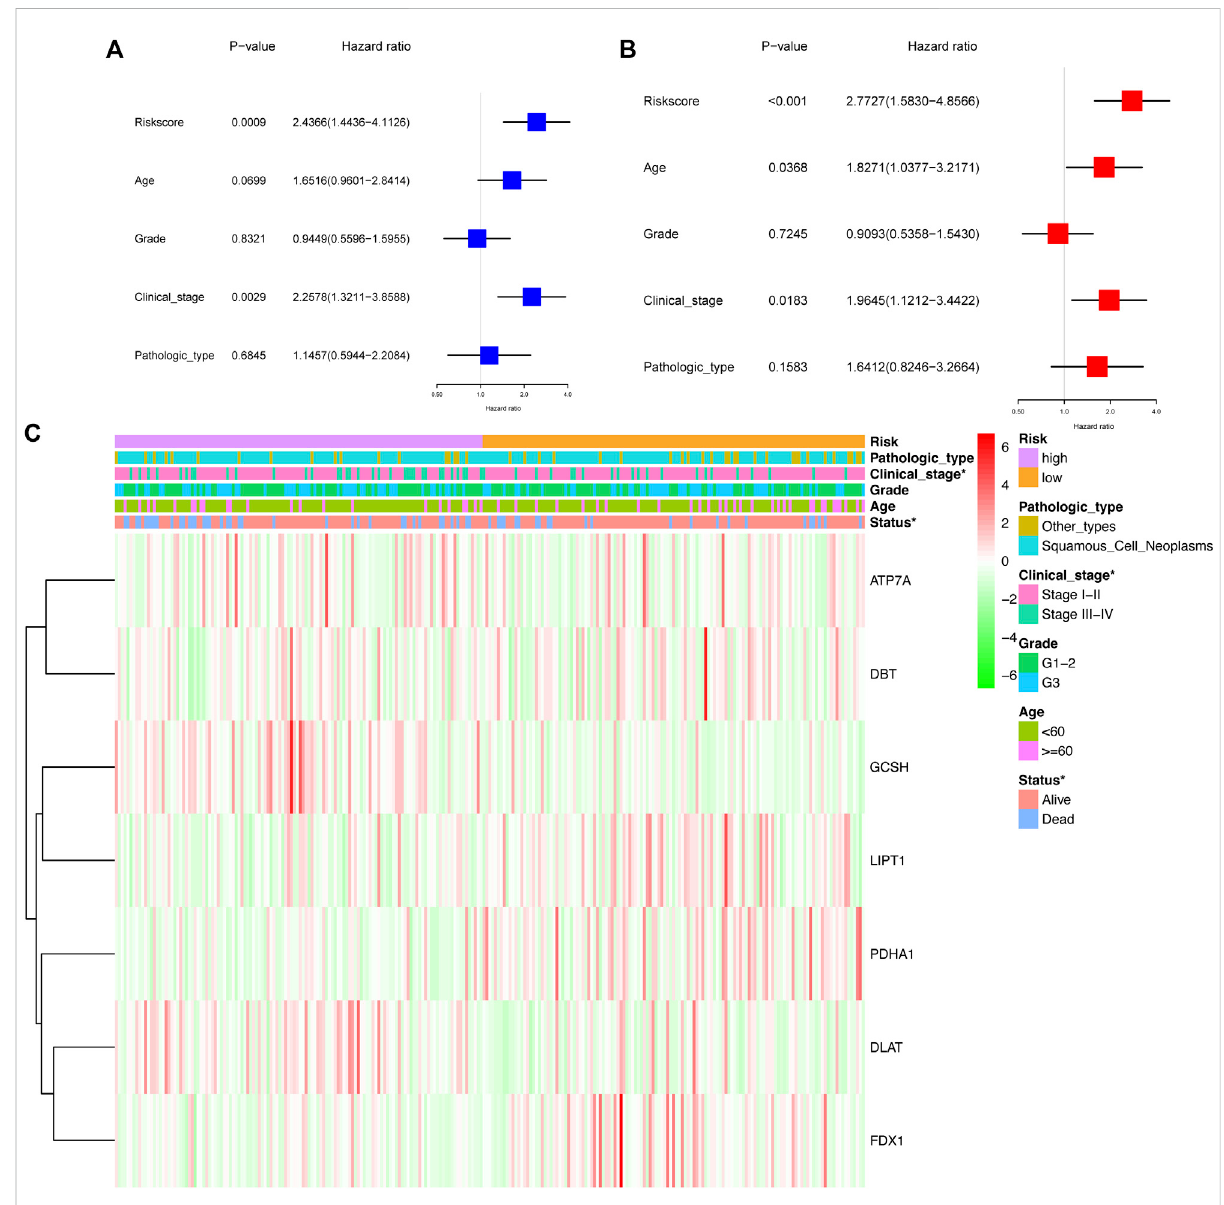
FIGURE 7 Prognostic value of the risk signature. Univariate Cox analysis (A) and multivariate Cox regression (B) regarding OS for the risk score in TCGA cohort. (C) Heatmap showed the association between clinical and pathological characteristics and in the two